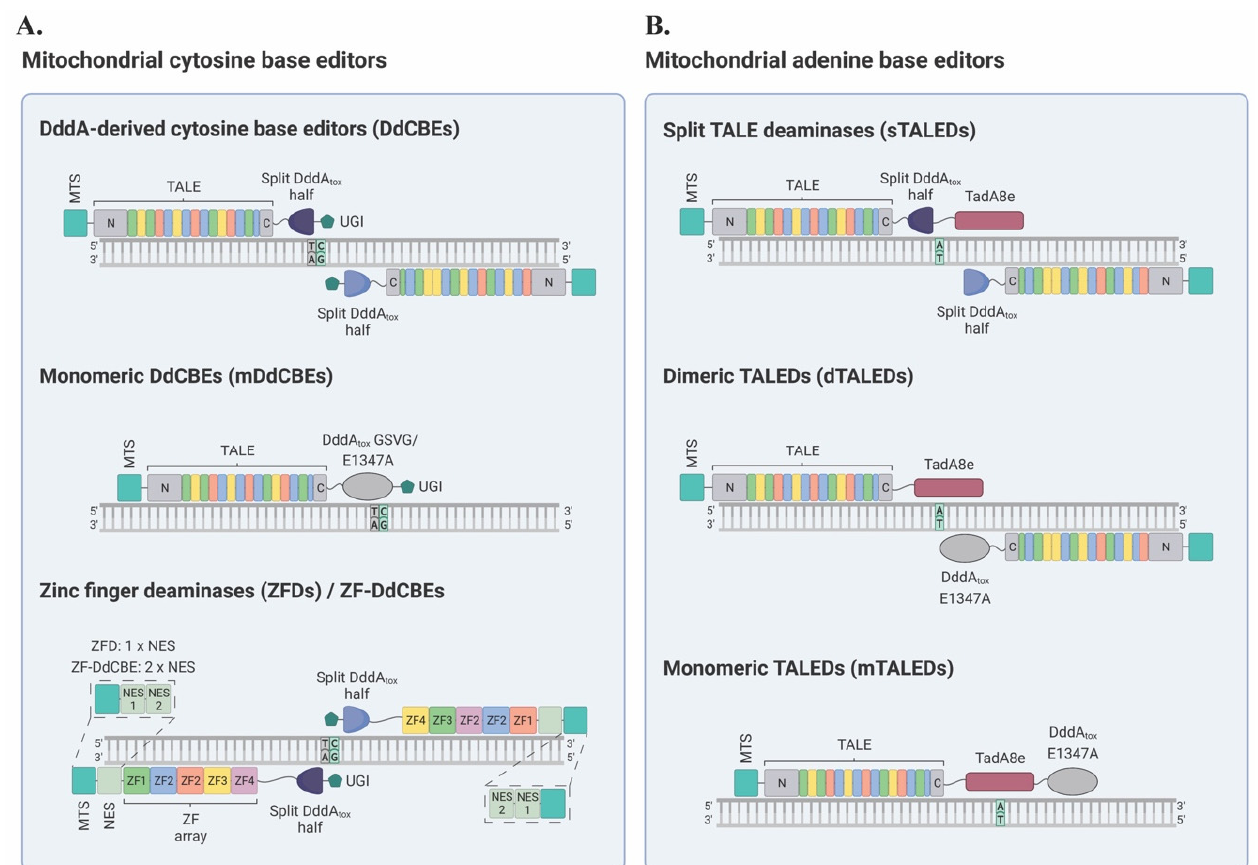
Figure 3. The mitochondrial DNA base editing toolbox. ( A ): Mitochondrial cytosine base editors. Target cytosines are shown in green, preceded by a 5 (cid:48) thymine in gray. Top: DddA-derived